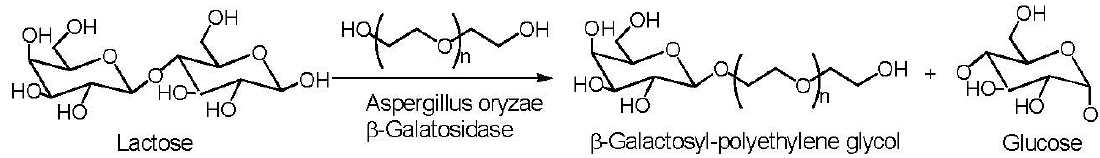
Figure 18. Formation of galactosylated poly(ethylene glycol) (PEG) through lactose- β -galactosidase reaction.